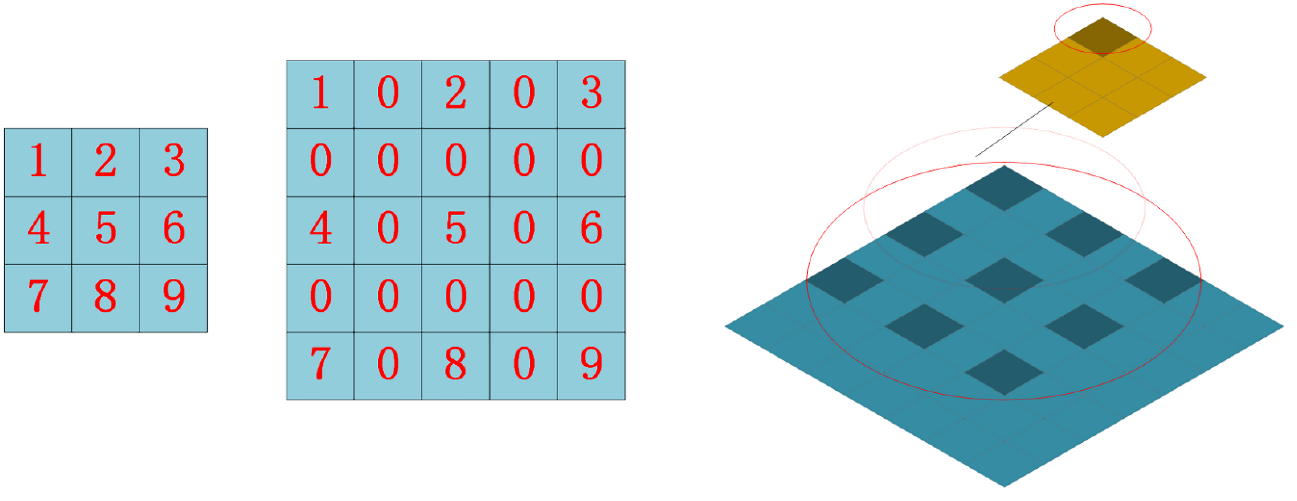
Figure 3. Atrous convolution display.